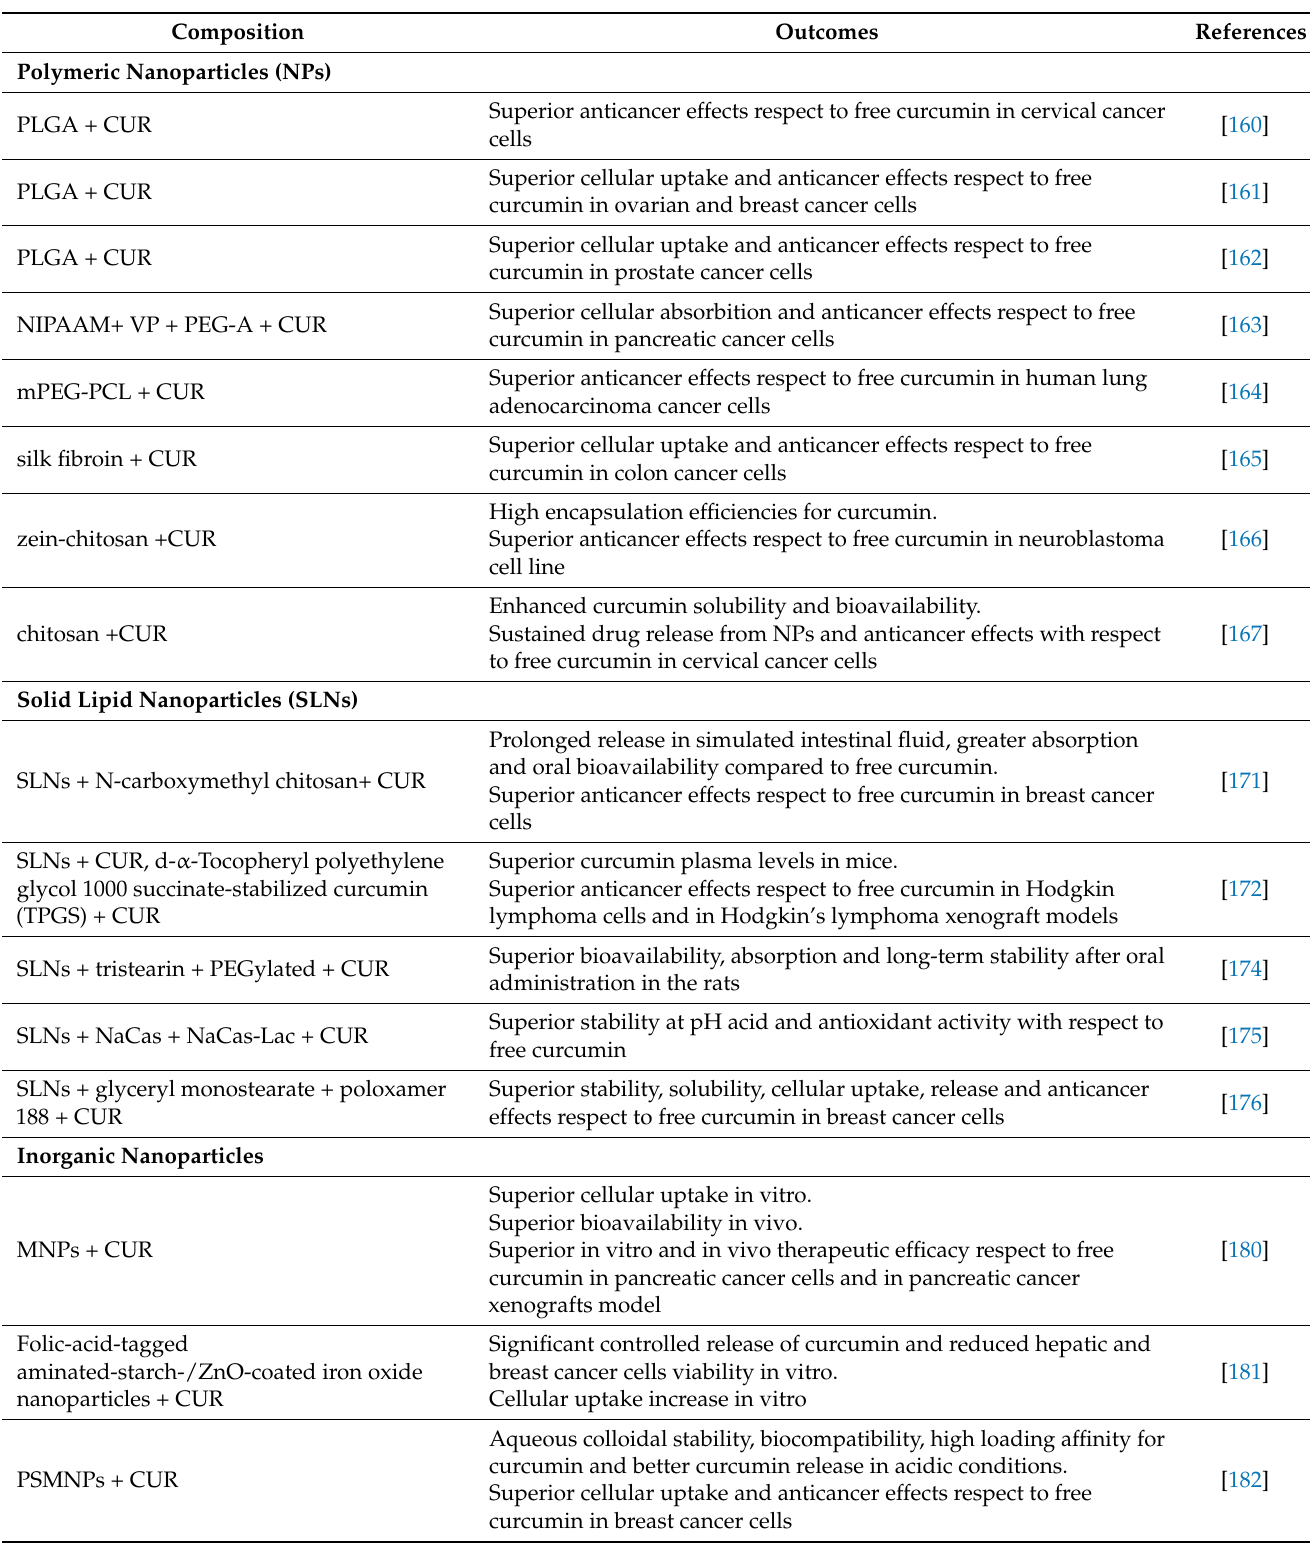
Table 2. Strategies to enhance bioavailability and/or antitumoral effects of